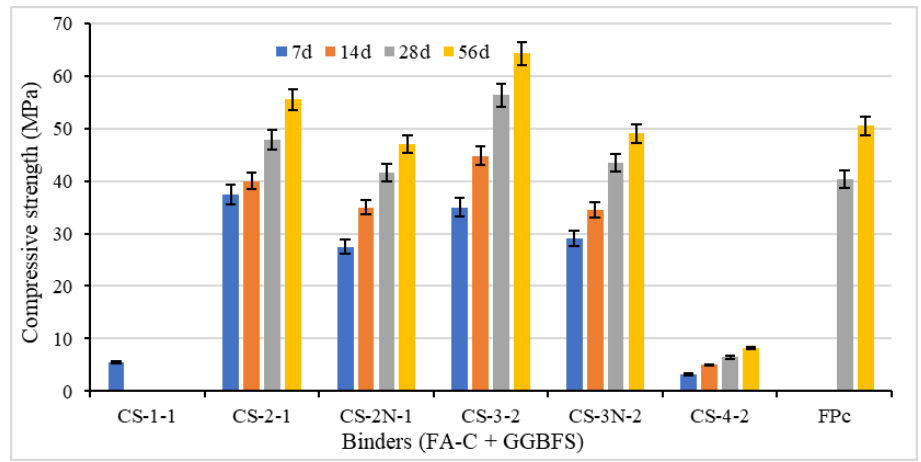
Figure 7. Influence of reagents (1 and 2) on binary binders (FA-C + GGBFS).